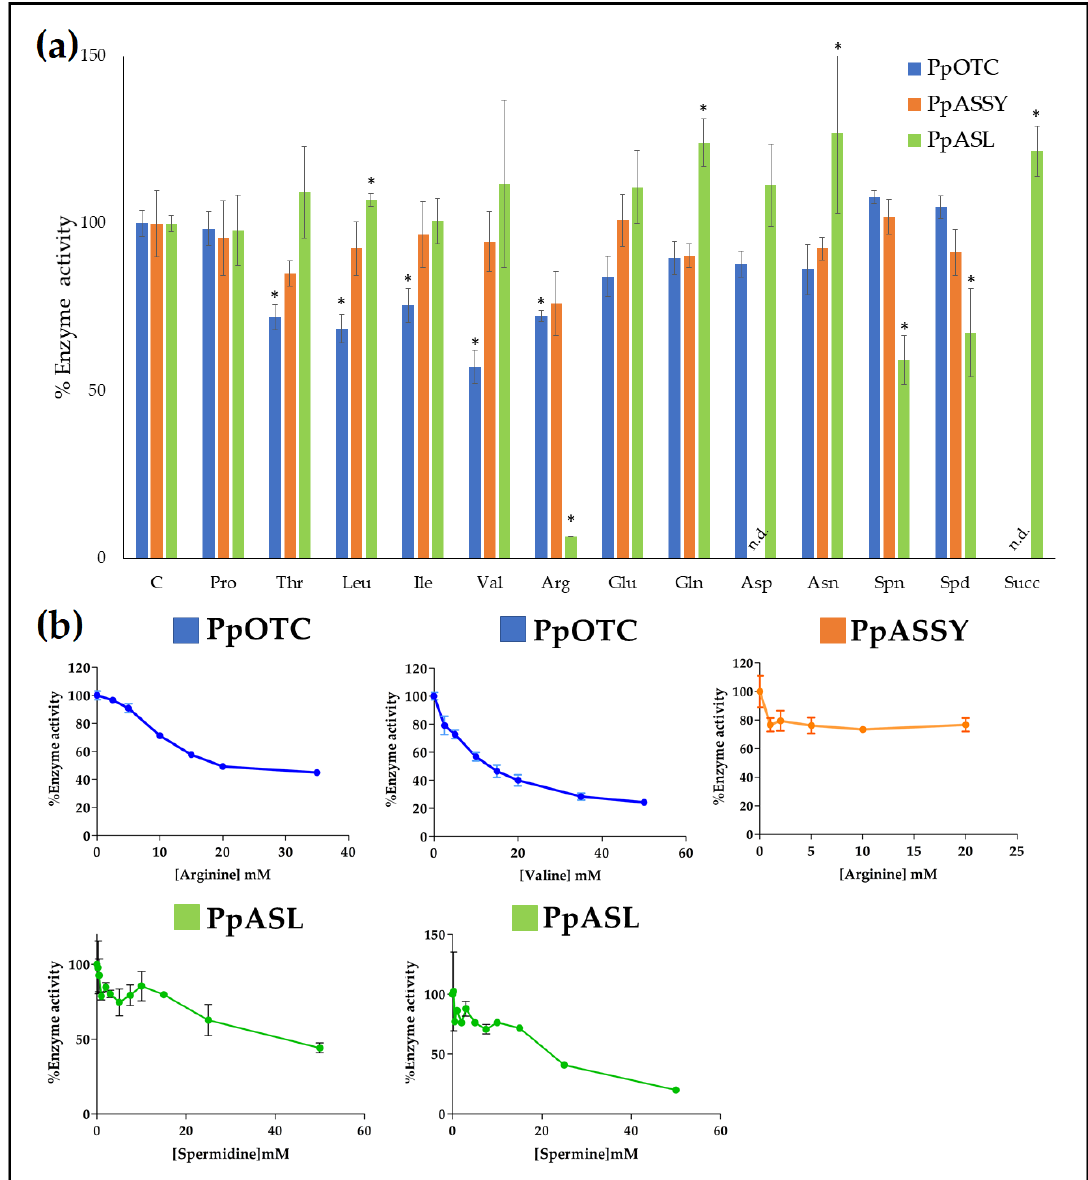
Figure 5. Effect of different compounds on the enzyme activities of PpOTC, PpASSY and PpASL. ( a ) The histogram shows the enzymatic activity of the three enzymes in the presence of different amino acids, spermine (Spn), spermidine (Spd) and succinic acid (Succ). N.d. for no determined data. The enzyme assays were performed in the presence of different compounds at a final concentration of 10 mM as described in the Material and Methods section. Enzyme activity levels in the absence of compounds were considered the controls, C (100%), and the corresponding values were 2.3 ± 0.1 nkat/μg for PpOTC, 0.21 ± 0.02 nkat/μg for PpASSY and 15.63 ± 0.41 nkat/μg for ASL. ( b ) Inhibition plots showing PpOTC, PpASSY and PpASL activities in the presence of increasing amounts of selected effectors indicated in panel ( a ) . (*) Significant difference vs. the control. All reactions were carried out with substrate concentrations greater than their respective K m (mM) values at 25 °C with vigorous shaking during 5 min (end point).